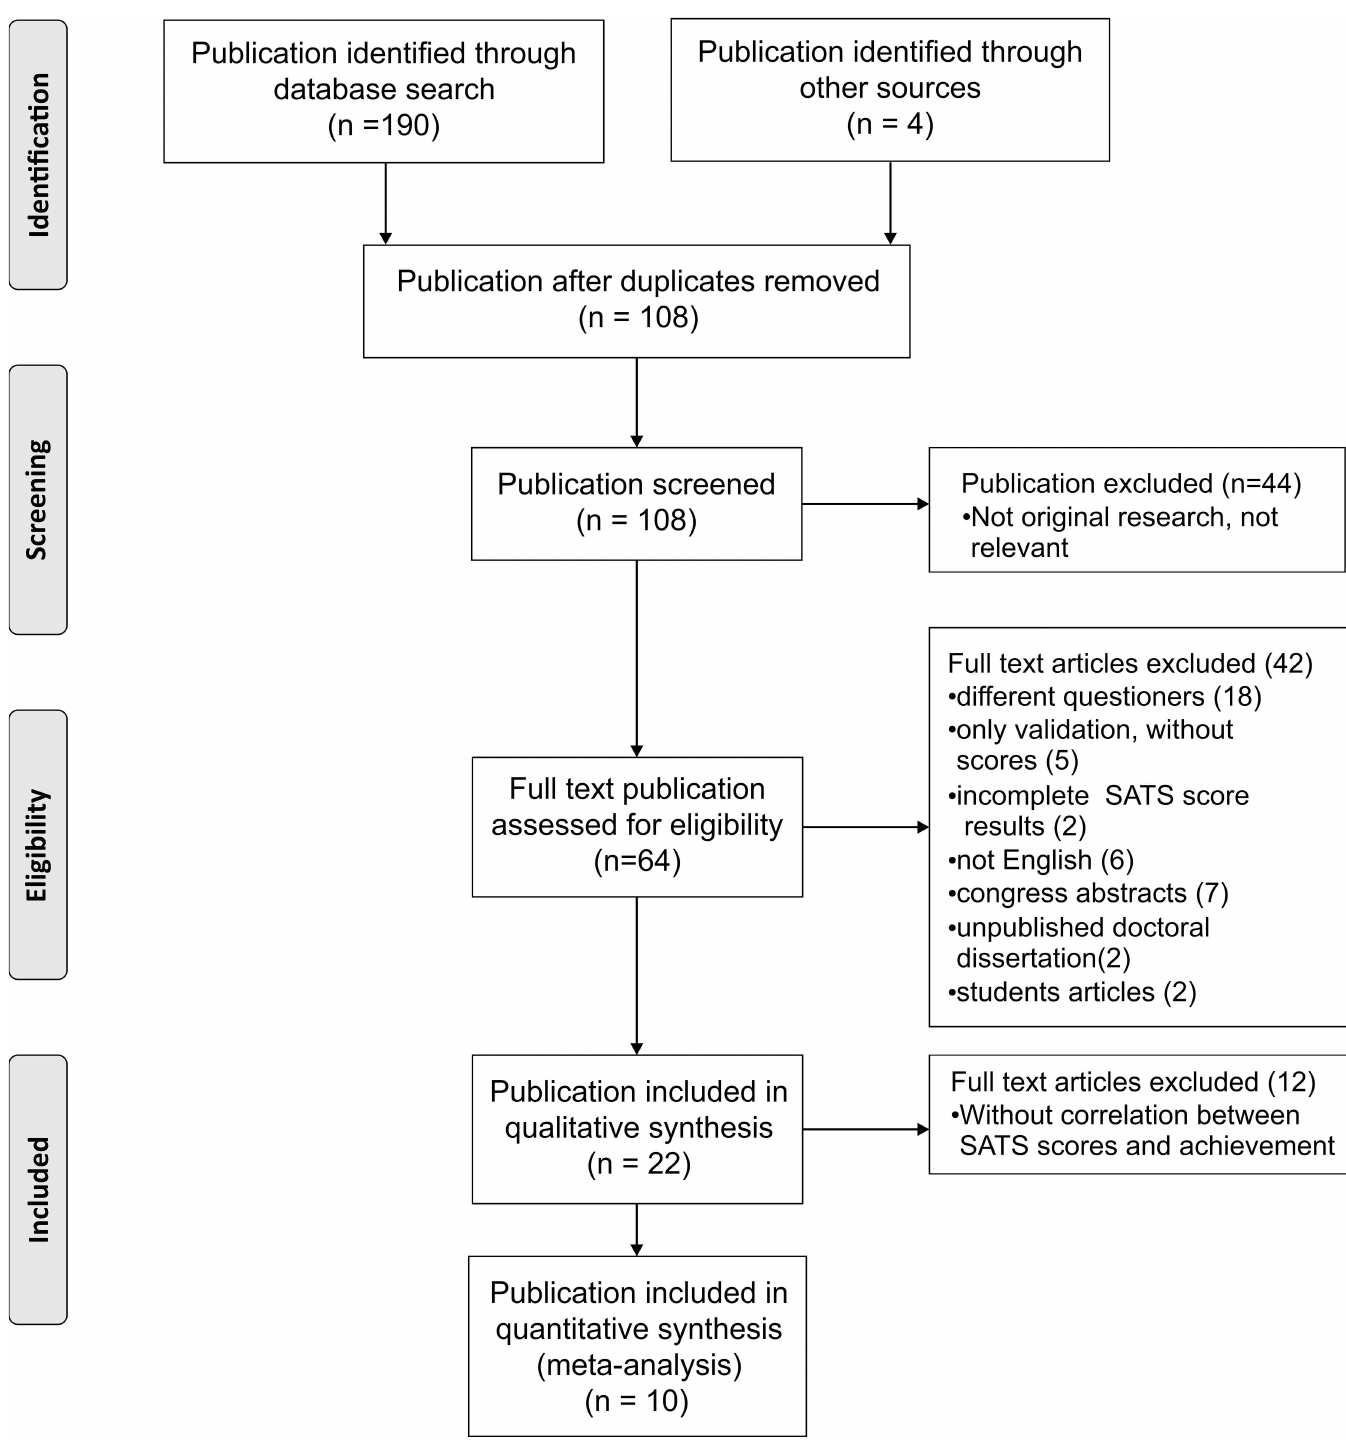
Fig 1. Flow of information through the different phases of a systematic review.